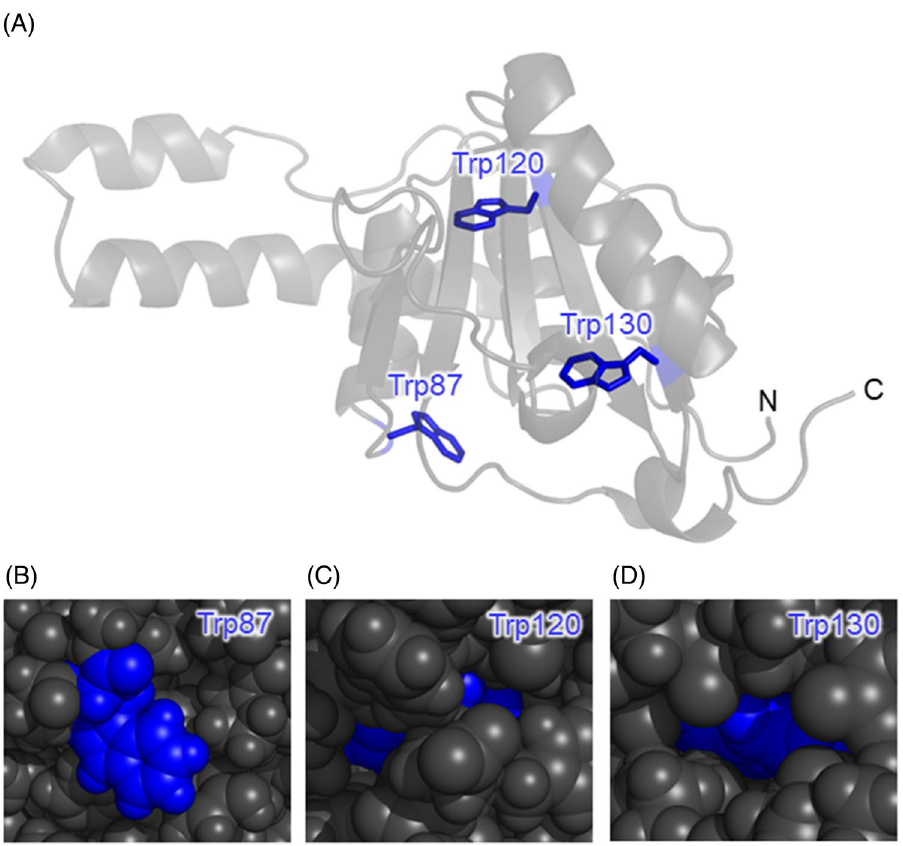
Figure 4. Solution NMR structure of JD of ataxin-3 (PDB code: 1YZB). ( A ) Three Trp residues, Trp87, Trp120, and Trp130 with blue sticks. ( B – D ) Magnified views of the protein structures around these Trp residues with van der Waals surface